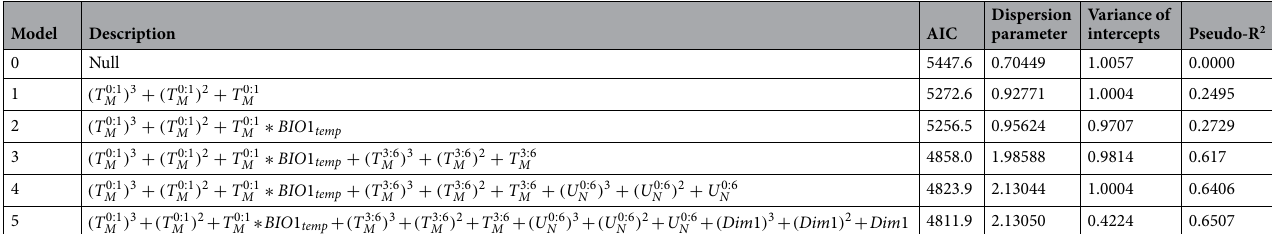
Table 2. The Akaike information criterion (AIC), dispersion parameter of the negative binomial regression, and the variance of the intercepts when sampling sites are considered a random effect. Asterisks indicated the interaction terms between 2 variables.